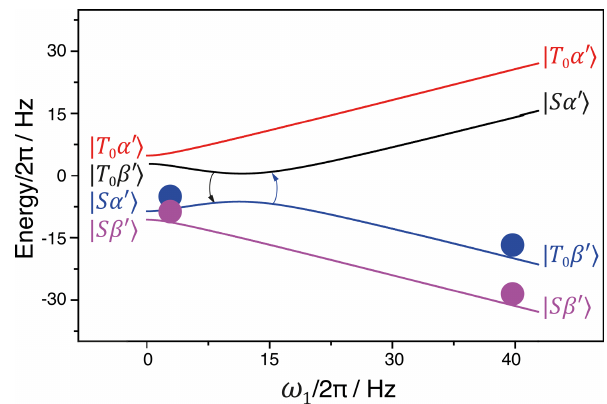
Figure 8. Population swapping upon increase in the amplitude of the RF field applied to the S spin. Simulation parameters: I and S nuclei are 1 H and 13 C, respectively; J II = 115Hz; J IS = 137Hz; δω = 2Hz. See text for further